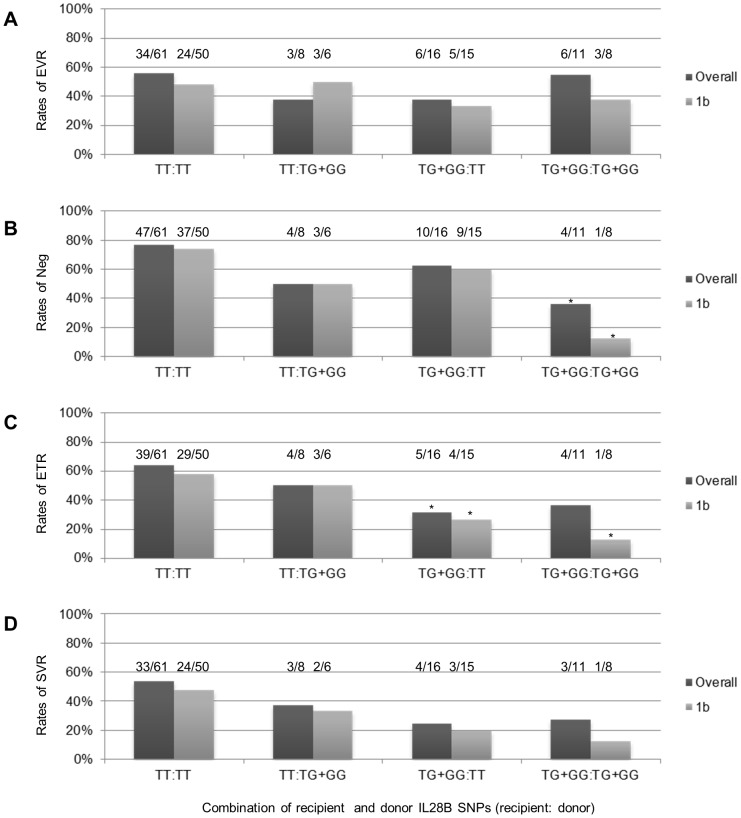
Combination of recipient and donor IL28B rs8099917 SNPs and corresponding rates of viral responses (A–D).A. Rates of EVR, B. Rates of recipients that presented with temporal non-detectable level of serum HCV RNA at least once during the course of INF treatment, C. rates of ETR, D. rates of SVR. Abbreviation: SNPs, single nucleotide polymorphism; SVR, sustained viral response; EVR, early virologic response; Neg, temporal non-detectable level of serum HCV RNA; ETR, end of treatment response. * indicates p = <0.05 v.s. combination of major allele both in the recipient and donor (TT:TT) with corresponding background.